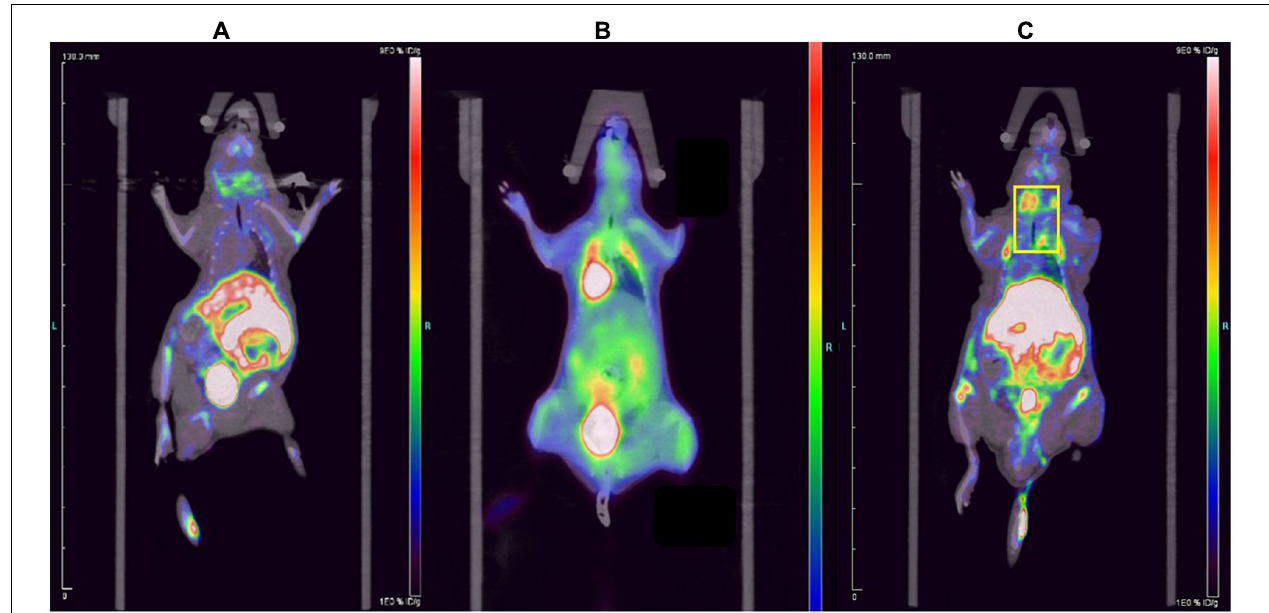
FIGURE 3 | Comparison of the (A) normal mouse, (B) 18 F-FDG imaging of carotid plaques in ApoE – / – mouse and (C) 18 F-ASEM imaging of carotid plaques in ApoE – / – mouse.